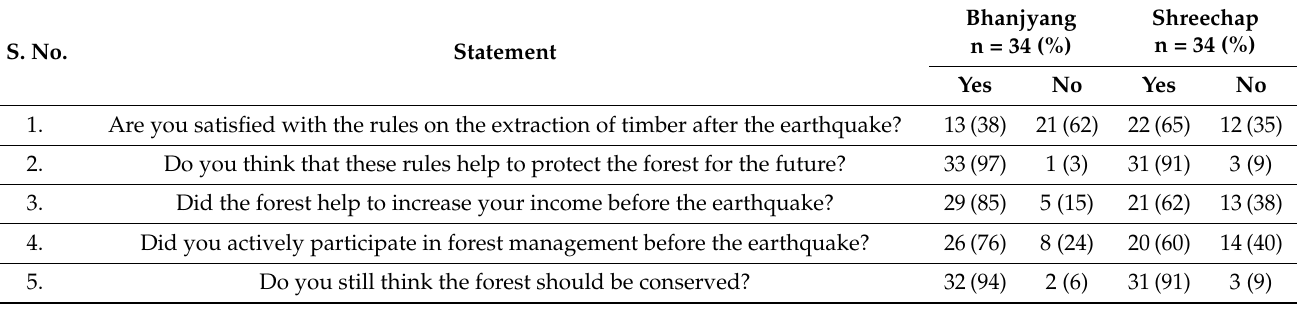
Table 4. Attitudes of CFUG households on forest